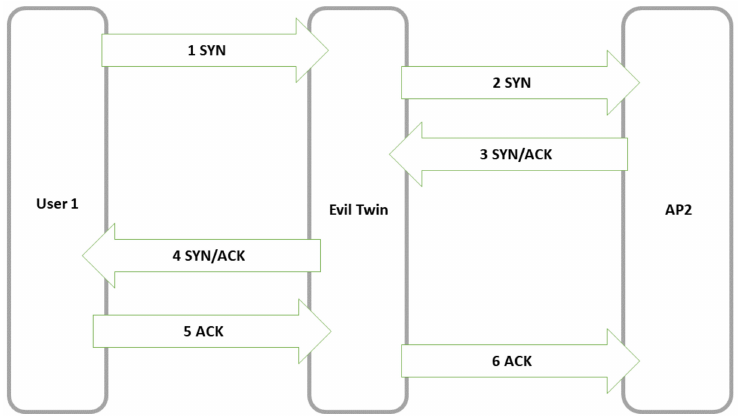
Figure 3. The packet sequence for the three-way handshake of User 1 was used to establish one TCP (Transmission Control Protocol) connection through an evil